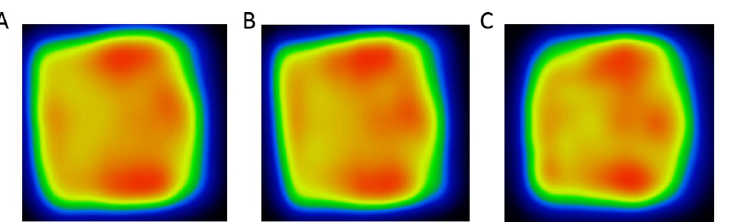
Fig 6. Representative axial sizes of the lesion measured and reconstructed by different scanners : Mediso AnyScan PET/CT (panel A), GE Discovery MI (4mm voxel size) on panel B, Mediso nanoScan PET/MRI (1.2mm voxel size) on panel C using spline interpolation.